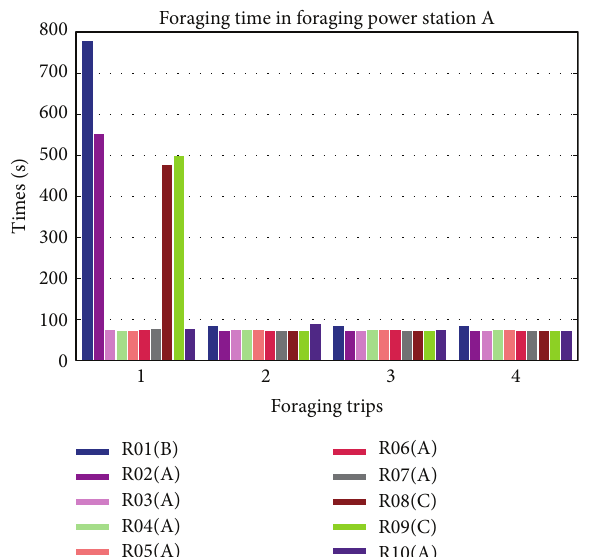
Figure 9: Time consumption in the foraging behavior of 10 mobile robots to power stations A, B, and